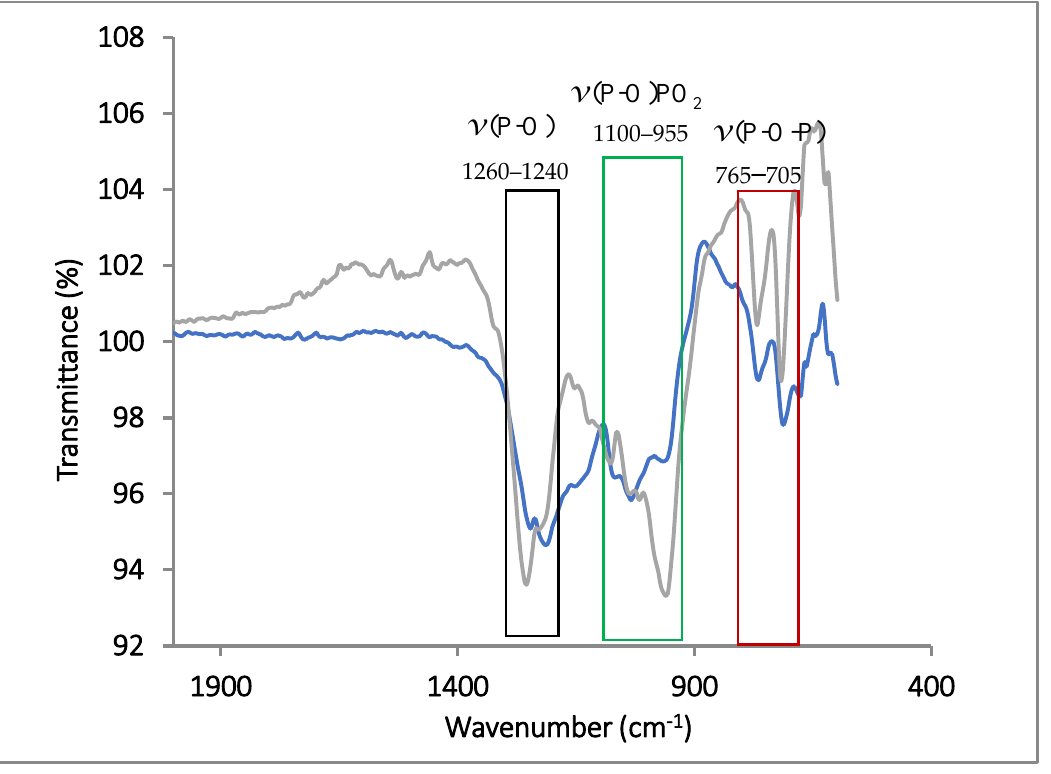
Figure 1. Infrared spectra of precipitates obtained after fusion of V 2 O 3 and AMIS 0501 mineral ore with ammonium phosphate salt as flux.